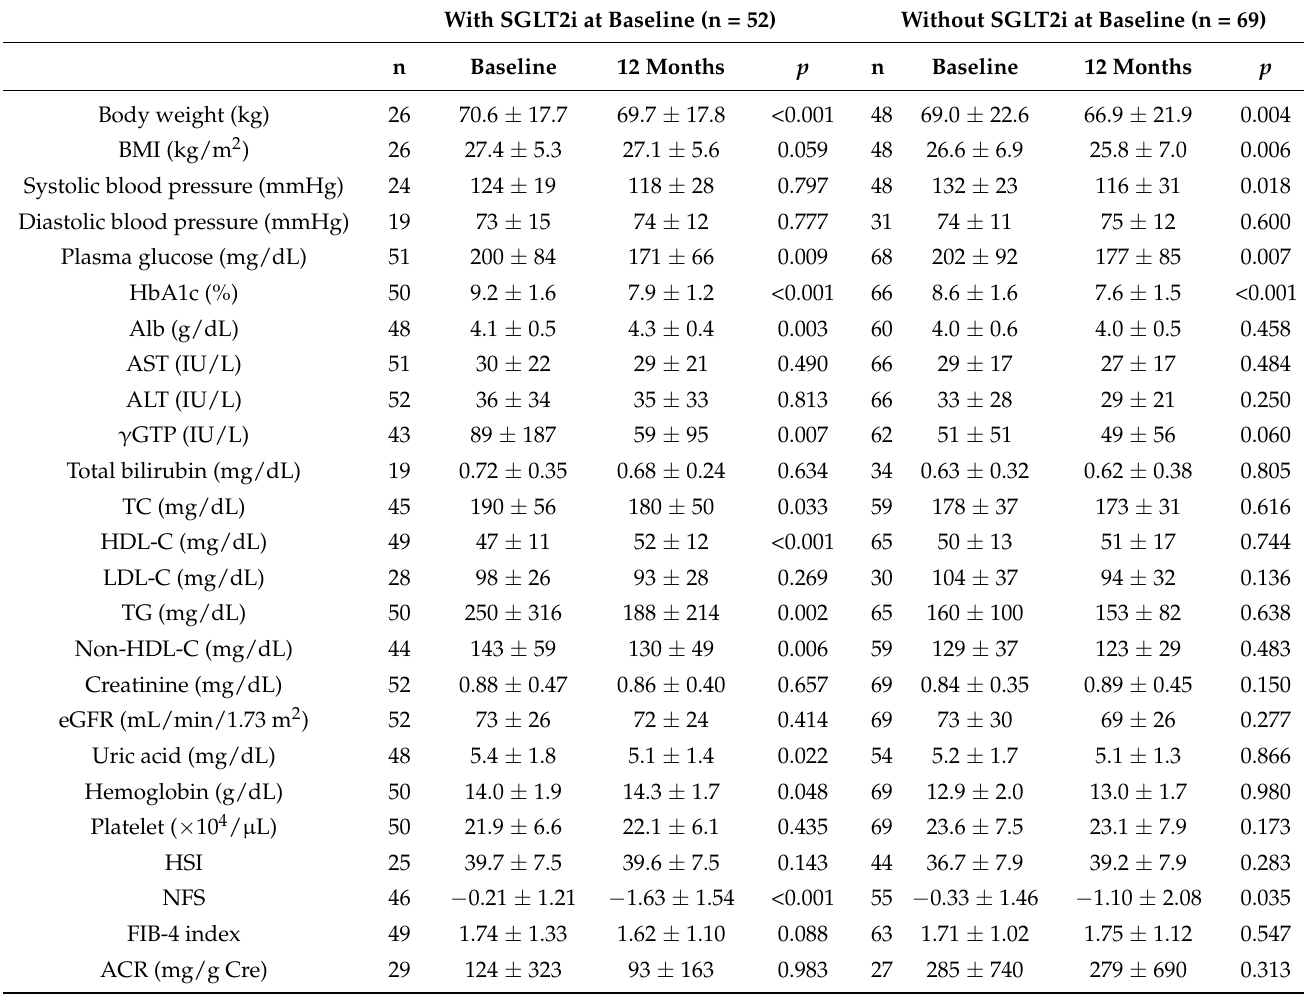
Table 6. Change in the clinical parameters 12 months after the start of dulaglutide in the subgroups with or without SGLT2i treatment at